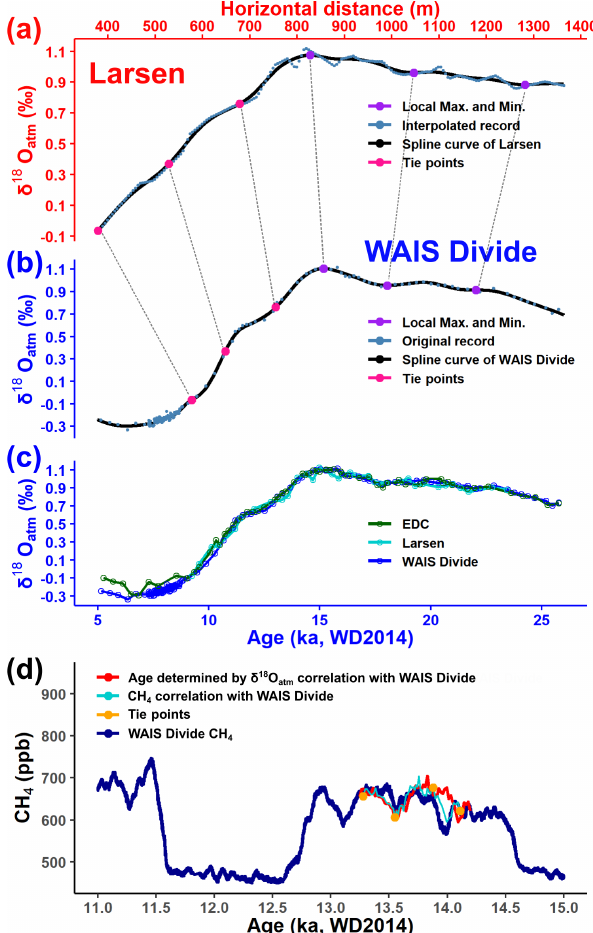
Figure 7. Correlation of Larsen δ 18 O atm and CH 4 records with the WAIS Divide. (a) Interpolated δ 18 O atm value at 5m from the Larsen BIA with a spline curve. (b) δ 18 O atm record from the WAIS Divide with a spline curve (Severinghaus, 2015). Six tie points were used to correlate each other. (c) Comparison of synchronized Larsen δ 18 O atm with the EDC (Landais et al., 2013) and WAIS Divide records. (d) Comparison of the CH 4 record from Larsen no. 23 ( > 4 . 6m depth) with the WAIS Divide (Rhodes et al., 2017). Ten- tative gas age determined by δ 18 O atm correlation with the WAIS Divide is tuned by correlating the CH 4 record using four tie points. The WD2014 timescale for the WAIS Divide and EDC is from Sigl et al. (2016) and Buizert et al. (2021),